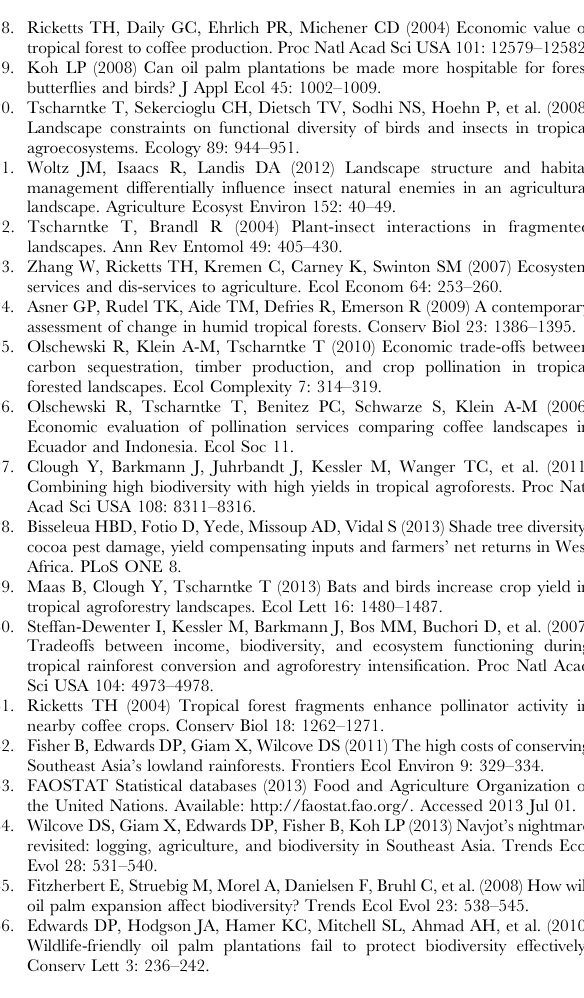
File S1 Table S1. Description of soil types found across the study area. Figure S1. Distribution of soil types across the study area. Figure S2. Distribution of elevation across the study area. Figure S3. Oil palm yield-by-age